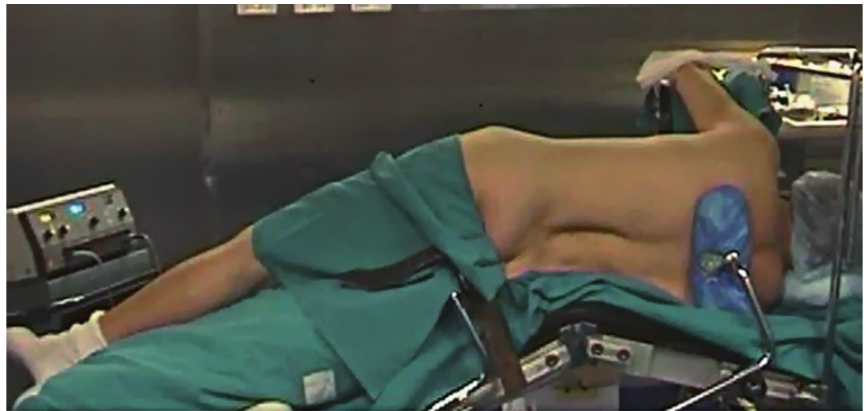
Figure 1 - Patient